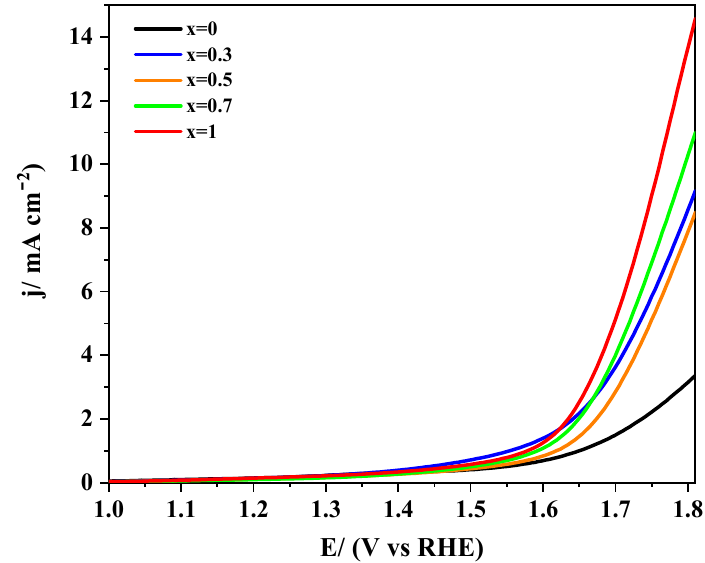
Figure 8. Linear sweep voltammograms recorded for LaMn 1 − x Co x O 3 perovskites mixed with Vulcan in the same mass ratio in 0.1 M KOH medium saturated with N 2 . Scan rate 5 mV/s.